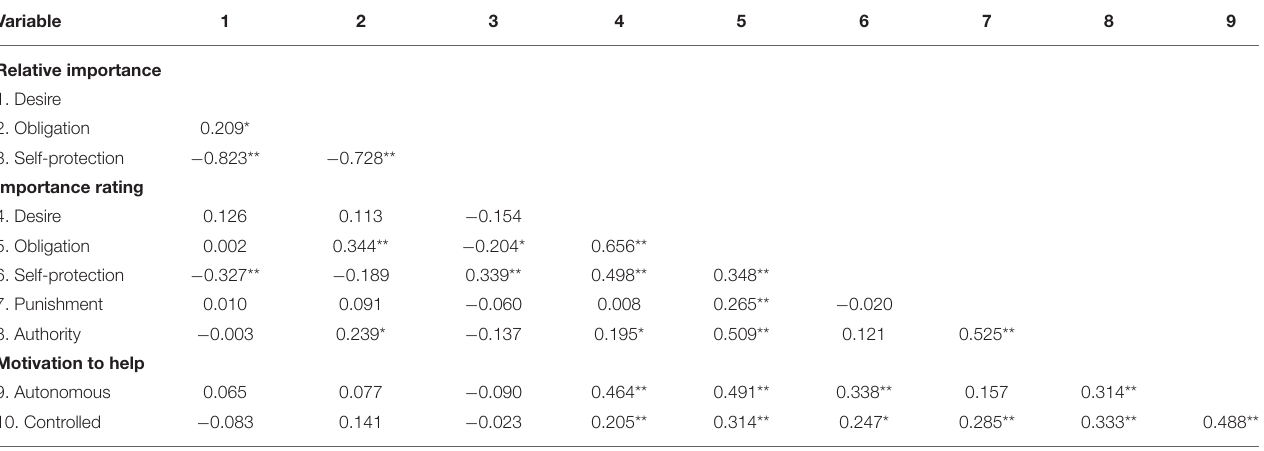
TABLE 1 | Correlations among different motivations in three measures—United States participants. Variable